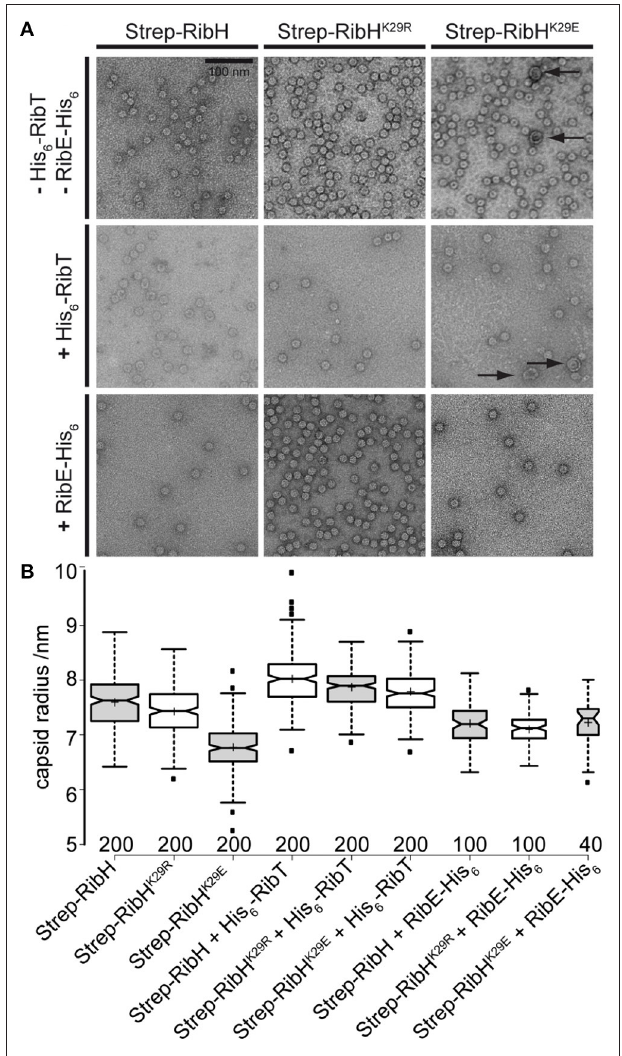
FIGURE 7 | In vitro analysis of Strep-RibH and mutant capsids by TEM. (A) Electron micrographs of purified capsids either produced without any accessory Rib proteins (top), coproduced with His 6 -RibT from another compatible plasmid (middle), or coproduced with His 6 -RibE from the same plasmid (bottom). The scale bar (top left) is 100nm and is valid for all electron micrographs shown. (B) Boxplots showing the statistical analysis of capsid radii as measured from electron micrographs using BoxPlotR (Spitzer et al., 2014). Medians are shown as black lines; notches represent the 95% confidence interval for each median. Sample means are shown as crosses, and the width of each box corresponds to the sample number, which is also given below each box. Outliers are shown as small, black